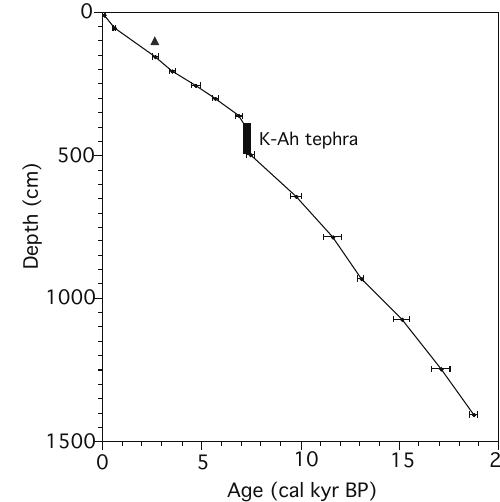
Figure 5. A depth versus calendar age diagram for core KY07-04- 01. Solid circles represent radiocarbon age control points obtained from planktic foraminiferal tests listed in Table 1. The triangle rep- resents datum rejected for the age model because it deviated from the trend; the bars represent a 2 σ error; the thick vertical bar repre- sents the interval corresponding to the K-Ah ash